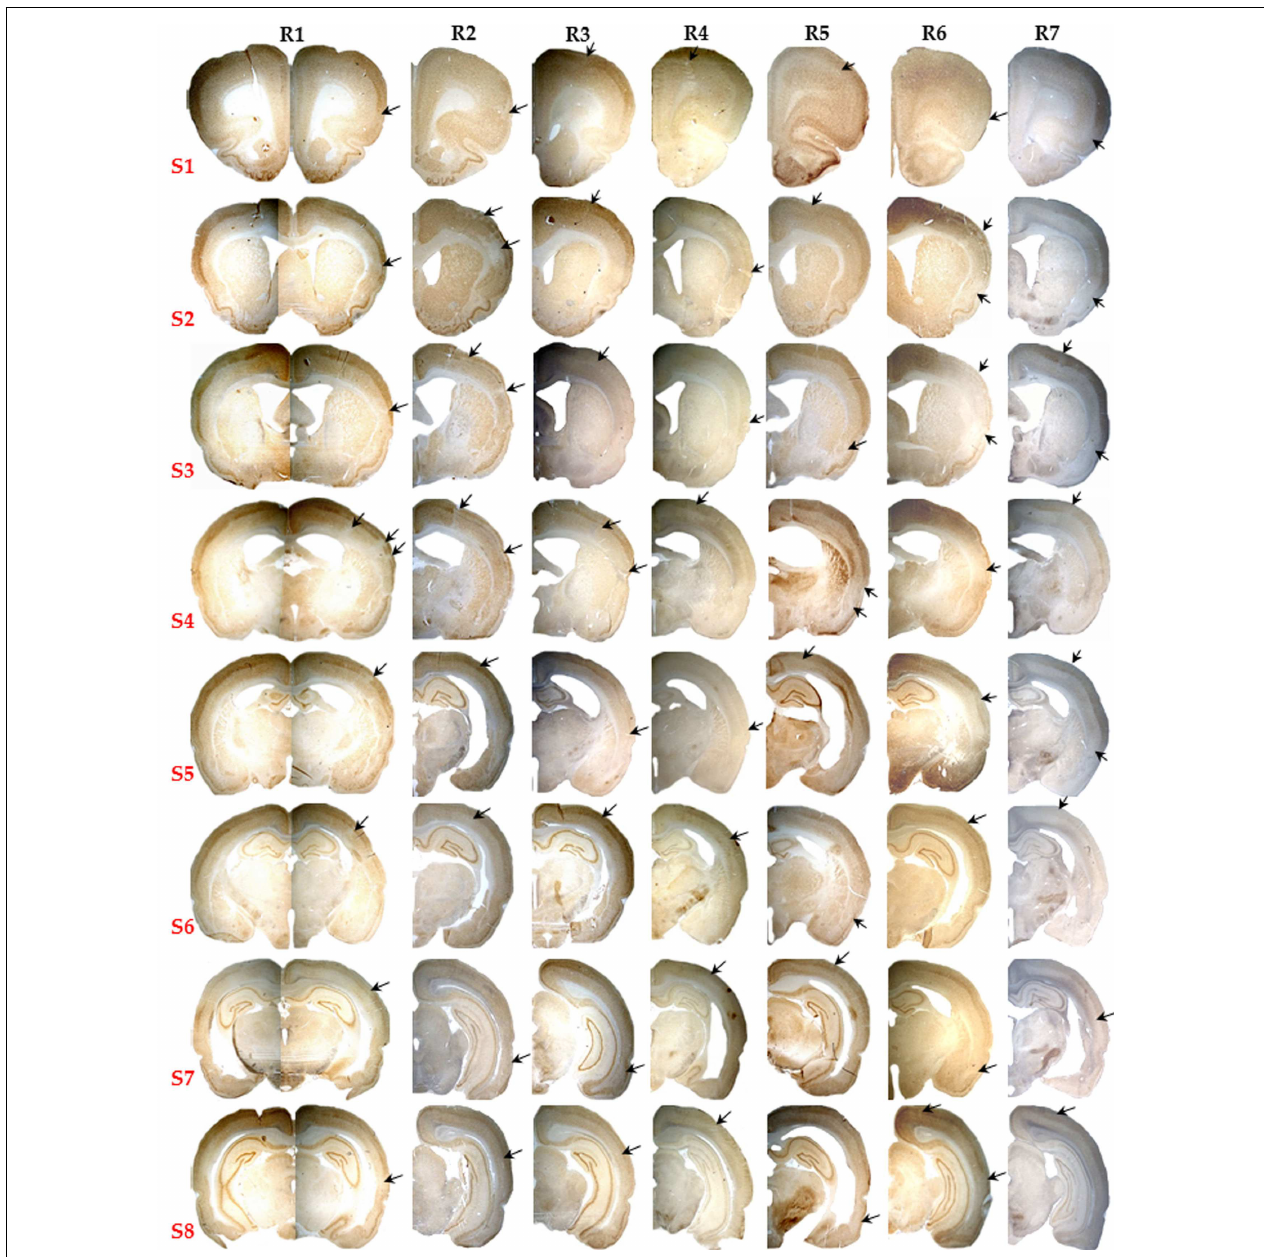
in any subject. Patchy areas of pure cortical selective neuronal loss (SNL) were present in each rat, and are pointed here by arrows even though they are not always easy to identify at this low magnification (see Figure 4 for